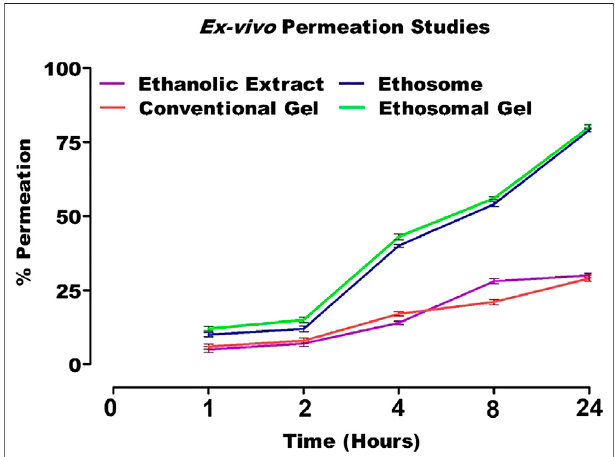
FIGURE 11 | In vitro release pro fi le of AM loaded formulations.